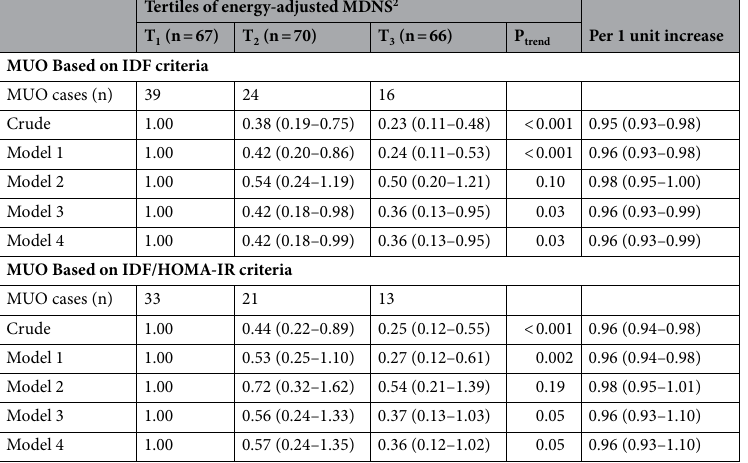
Table 3. Multivariable-adjusted odds ratio for MUO across tertiles of methyl donor nutrients score (n = 203) 1 . 1 All values are odds ratios and 95% confidence intervals. Model 1: Adjusted for age, gender, energy intake. Model 2: More adjustments for physical activity levels, socioeconomic status. Model 3: Further adjustments for iron, niacin, saturated fatty acids. Model 4: More adjustment for BMI. 2 MDNS components were adjusted for energy intake based on residual